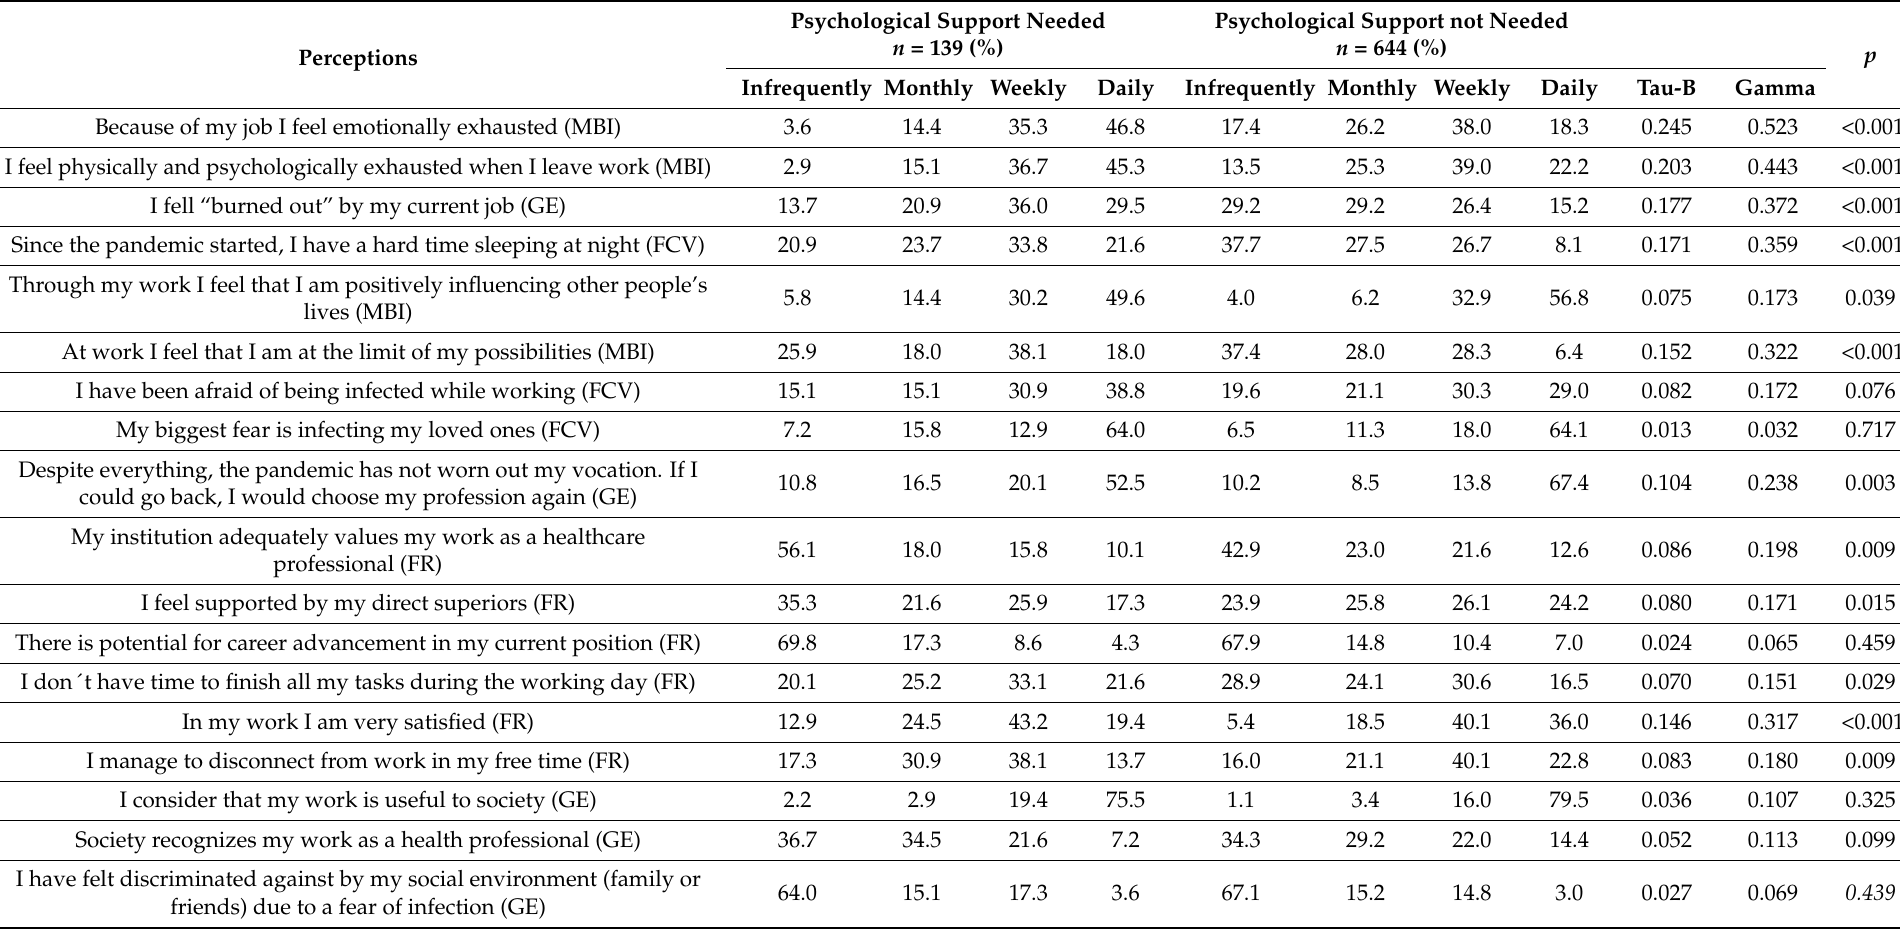
Table A3. Working perceptions of the health professionals according to whether or not they required psychological help, and correlations with the ordinal and frequency variables using Kendall’s Tau B.